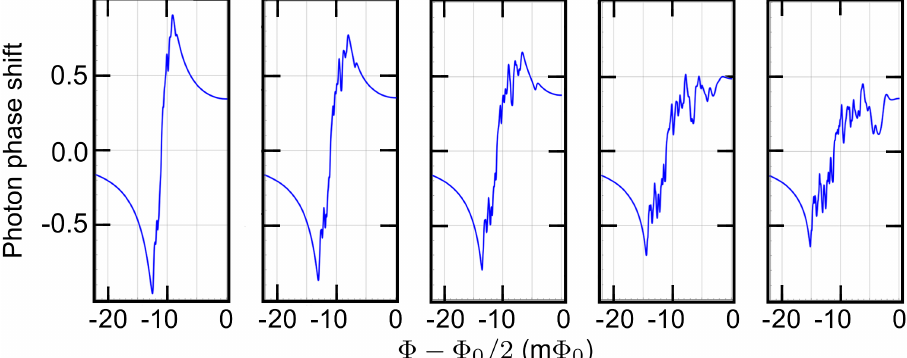
Figure 2. Numerical results for the phase shift ϕ (Φ) at qubit energy gap disorder σ of N = 20 , 50 , 100 , 250 , 500 qubits.